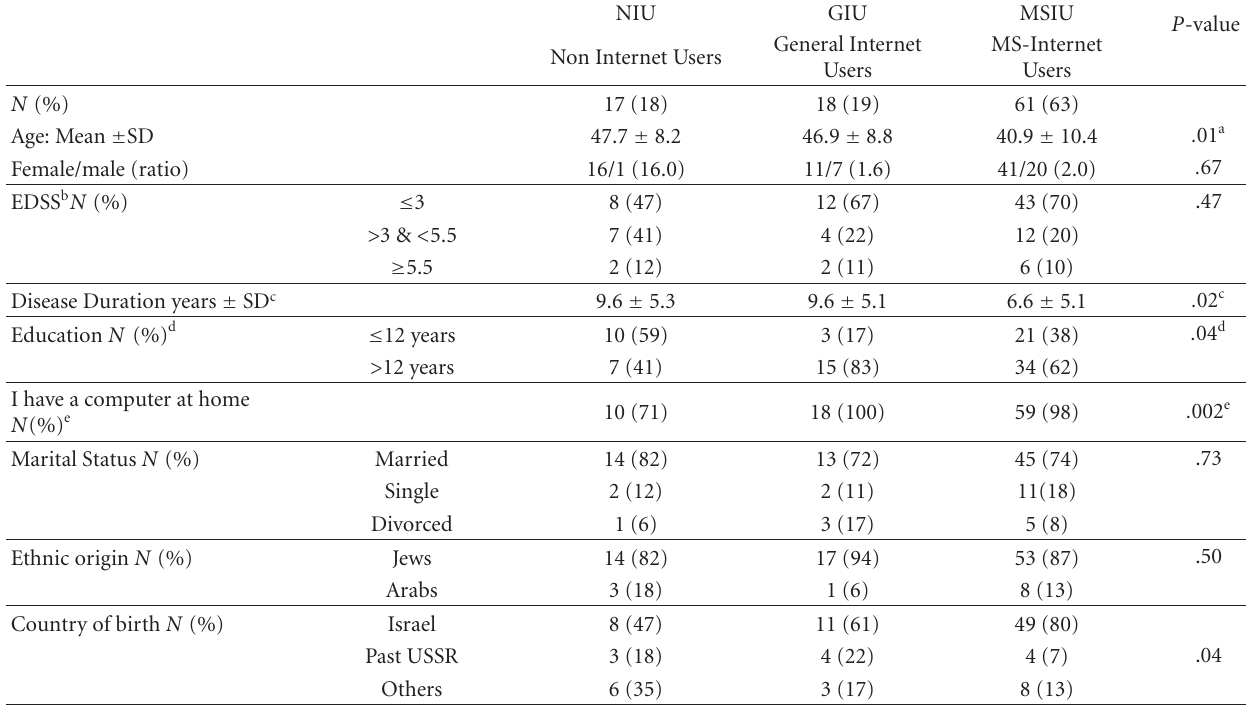
Table 1: Demographic and clinical characteristics of study